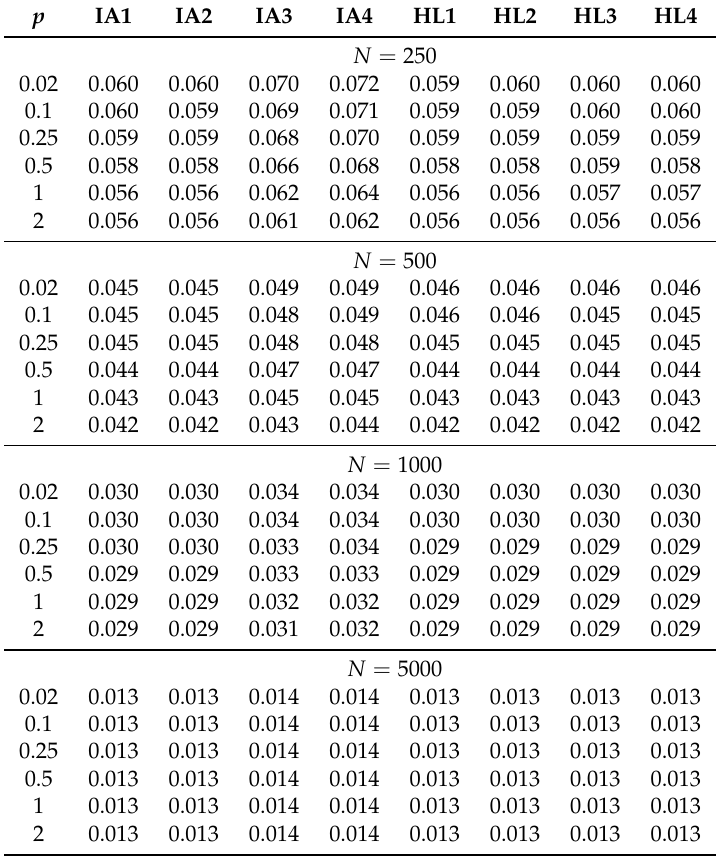
Table 1. Simulation Study 1: Average Root Mean Square Error (ARMSE) of Group Means as a Function of Sample Size in the Condition of No Differential Item Functioning (No DIF) and G = 6